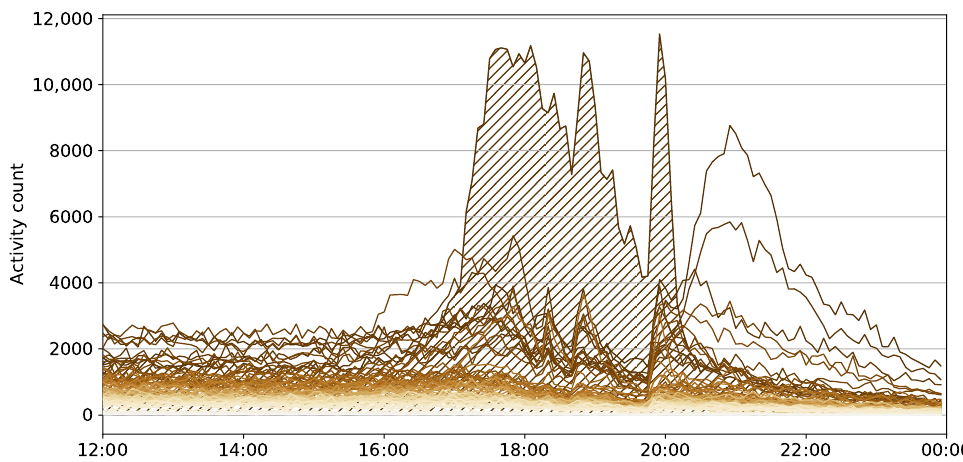
Figure 13. Site activities in Budapest downtown on the day of the Hungary vs. Portugal football match (22 June 2016). The highlighted site covers the Szabadság Square, where one of the main fan zones was set